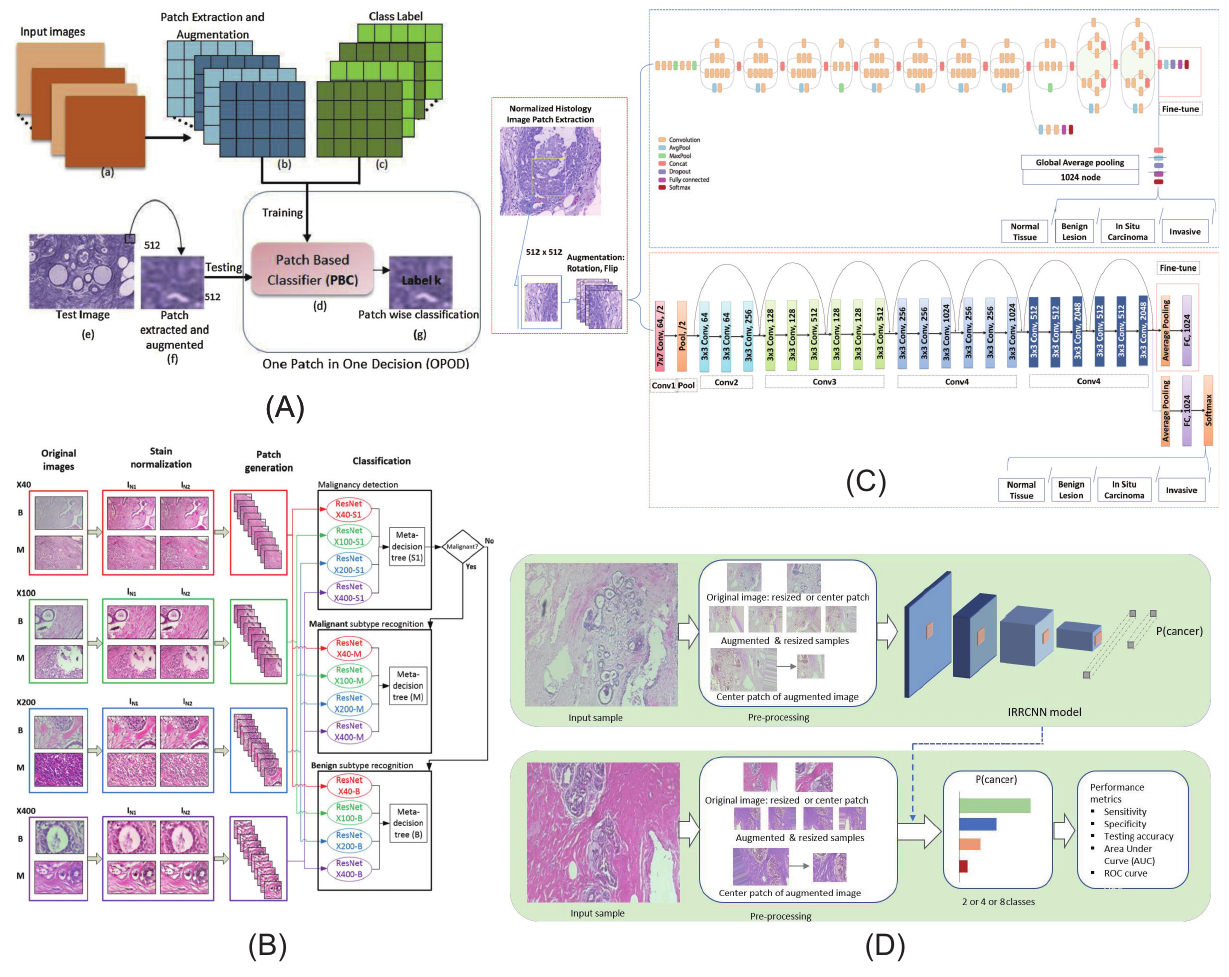
Figure 5. Some typical models of disease classification based on breast pathological images. ( A ) The block diagram of patchwise classification and the block diagram of the CNN architecture reported by Roy et al. ( B ) The steps of MuDeRN reported by Gandomkar et al. ( C ) The workflow of breast histology image classification reported by Vesal et al. ( D ) Alom et al., reported the implementation diagram of the IRRCNN model to identify breast